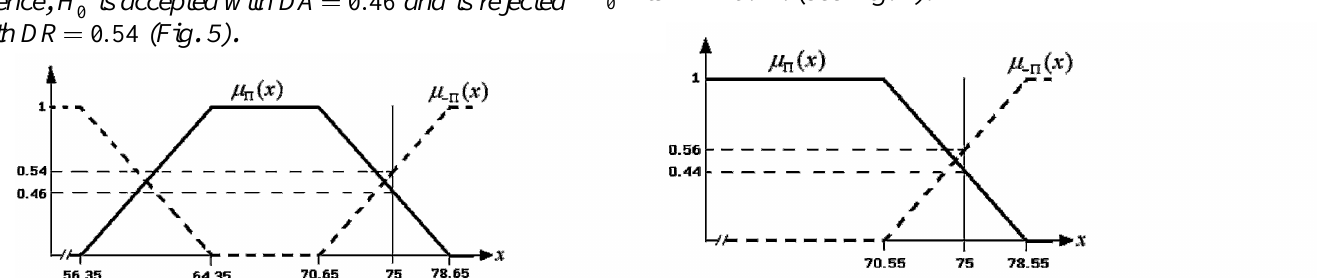
Fig. 7. H is accepted with 0